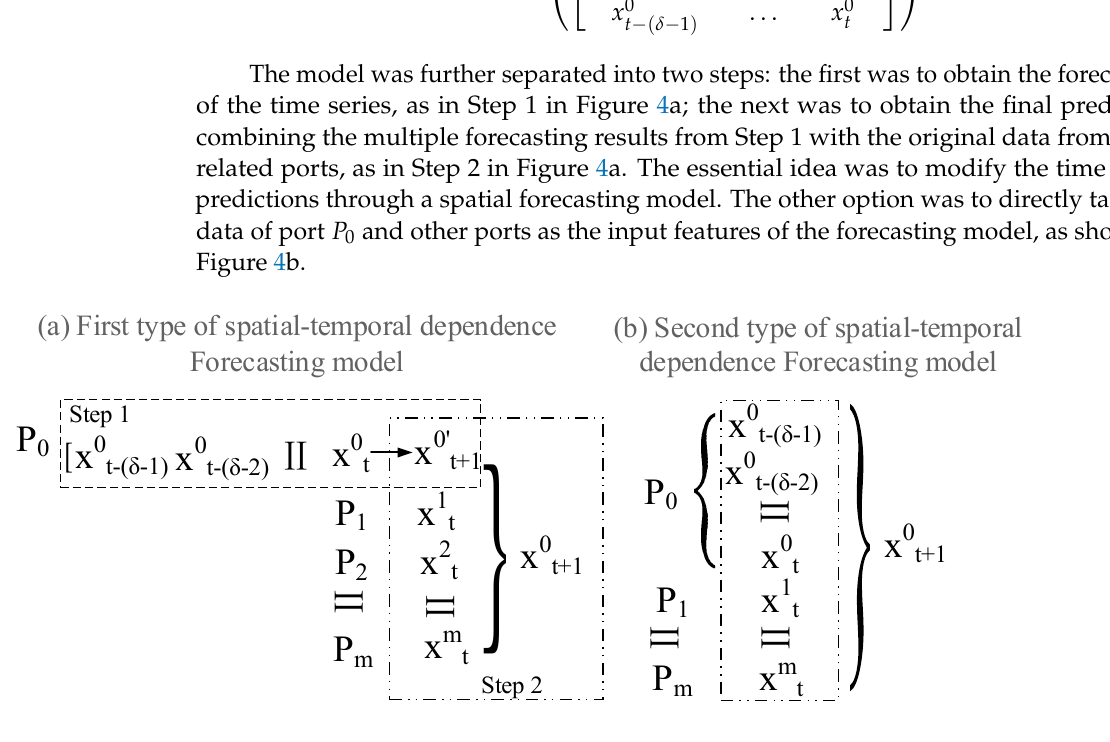
Figure 4. Schematic diagram of the forecasting model.